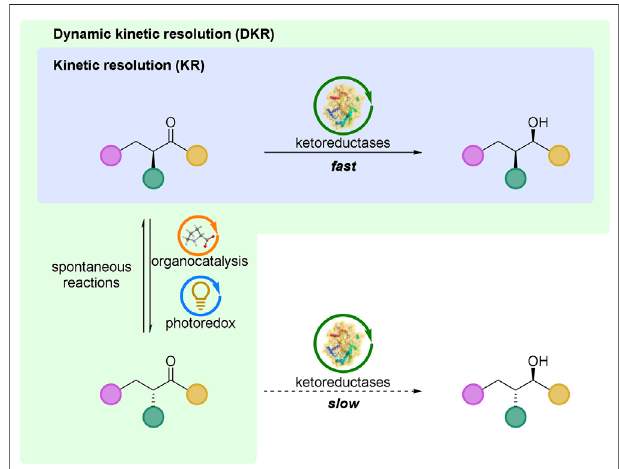
FIGURE 1 | Kinetic resolution (KR) and dynamic kinetic resolution (DKR) based on ketoreductases catalyzed reductions. For both KR and DKR, the racemic substrate was used as the start material, and only one of the enantiomers with a faster rate was highlighted in KR process for a clear explanation.